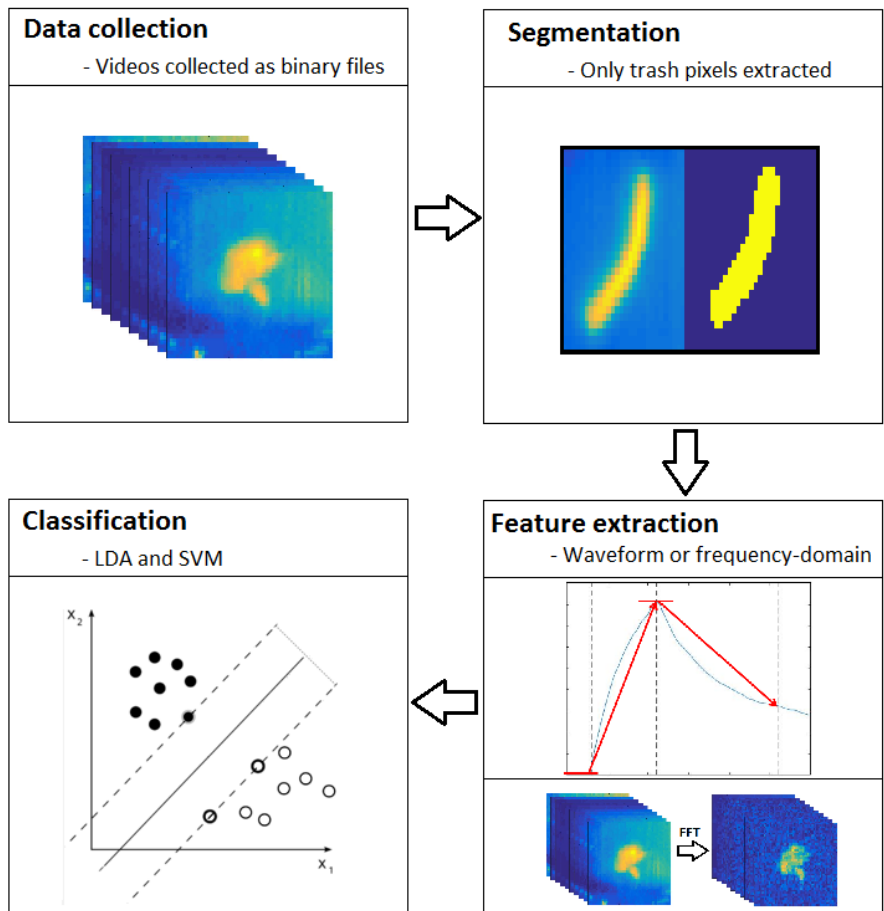
Figure 6. Diagram of the data processing pipeline.